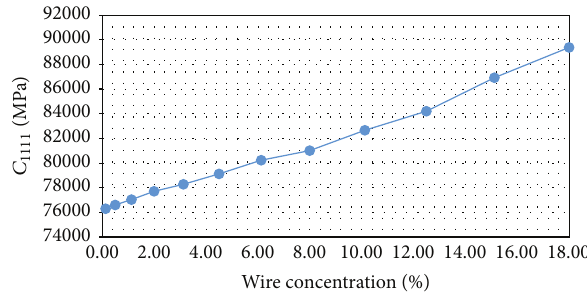
Figure 3: Dependence of coefficient versus concentration of reinforcing wires.